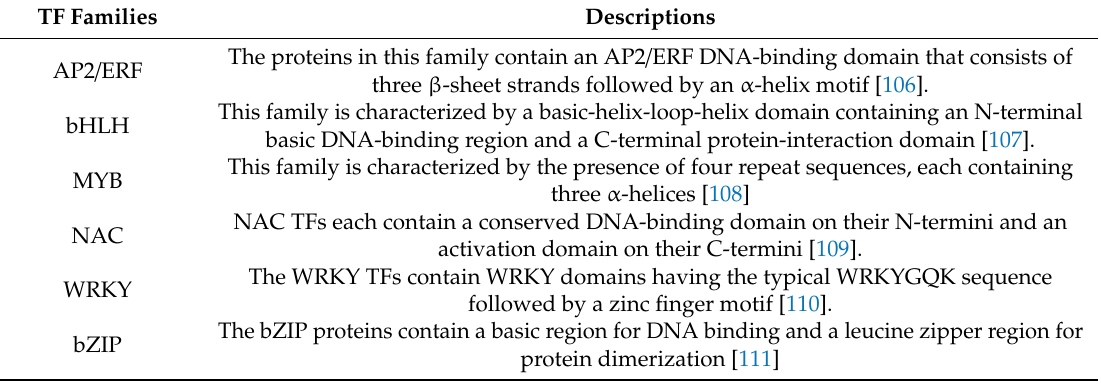
Table 1. The major transcription factor (TF) families involved in plant